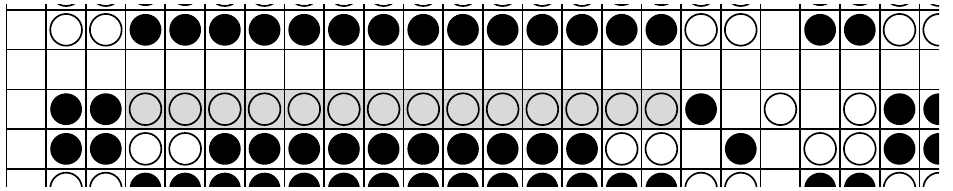
Figure 18. BLACK wins. Figure 6 locates stoppable squares over the crossings (cid:77) , called stops . The free men can move along the passages freely but must halt at only these stops.